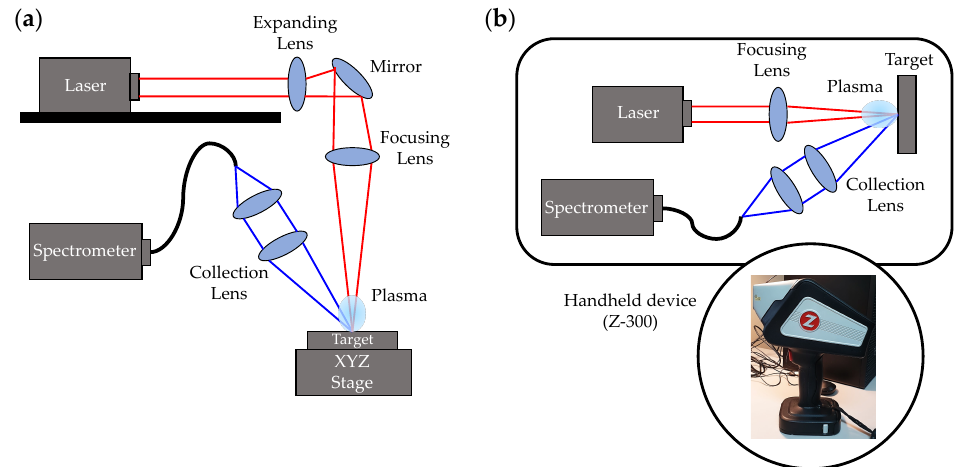
Figure 1. Schematic diagram of LIBS system setup; ( a ) benchtop system and ( b ) handheld system.